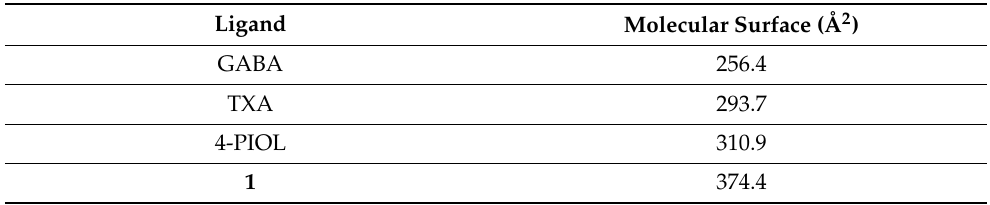
Figure 9. Binding poses with GABA binding pocket of GABA A receptor for tranexamic acid ( left ) and 4-PIOL ( right ). GABA A receptor file obtained from PDB code 6d6u. Table 2. Molecular surfaces calculated for GABA, TXA, 4-PIOL, and compound 1 .